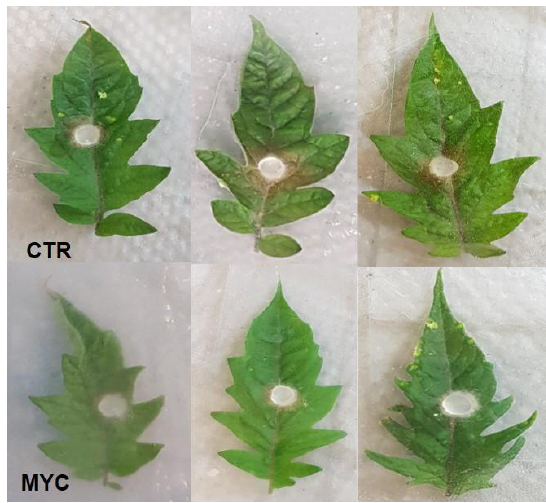
Figure A2. S. sclerotiorum infection on tomato leaves estimated by measuring the diameter of the necrotic lesion on MYC and CTR plants at 27 hpi (hours